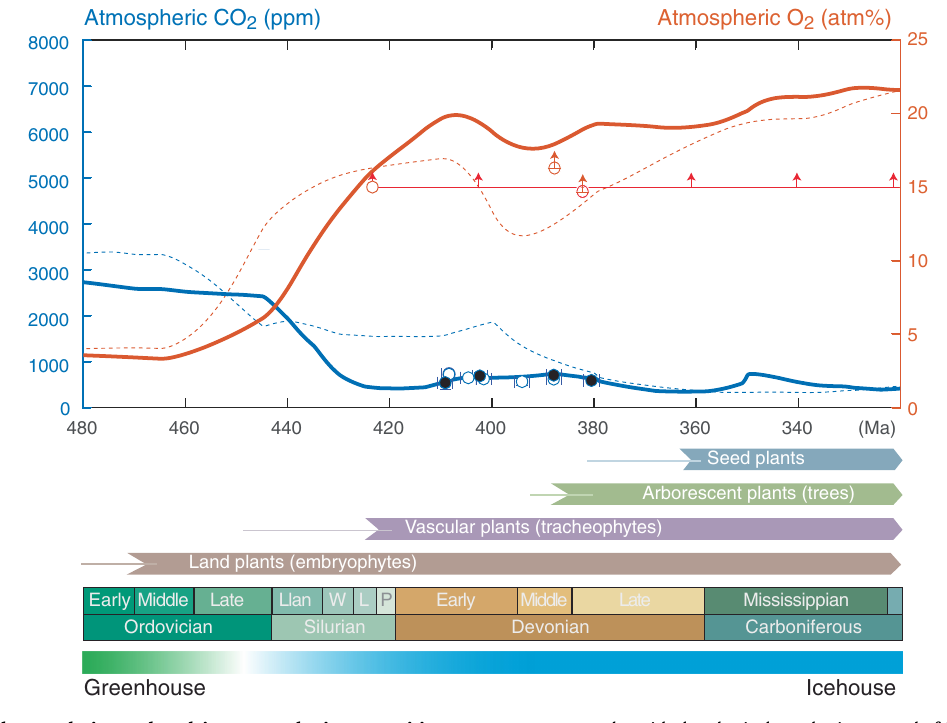
ecosystems scales with the physical weathering record of fi nes in terrestrial deposits 46 andoutgassingfromtheEarthscaleswithcontinentalarcvolcanism.The ‘ COPSE reloaded ’ model are shown for comparison (thin, dashed curves) 12 . For further details, see supplementary information. The emergence of land plants, vascular plants, arborescent plants with deep root systems and seed plants are shown with thin lines representing their origin by molecular clock estimates and thicker arrows representing fossil occurrences 45 . Llan Llandovery, W Wenlock, L Ludlow, P Pridoli. The uncertainty of absolute age assignments are de fi ned biostratigraphically, approximately